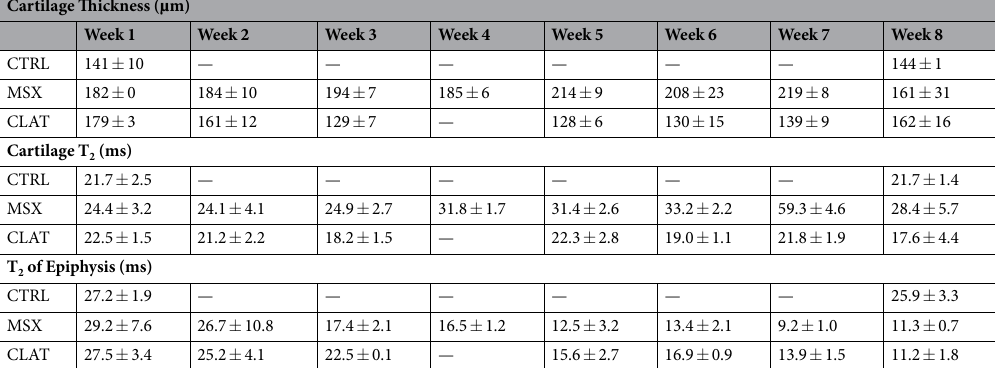
Cartilage Thickness ( µ m)